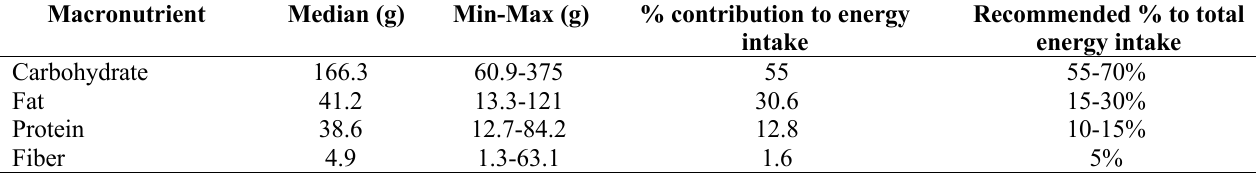
Table 2 . Macronutrient intake of participants (N=211)